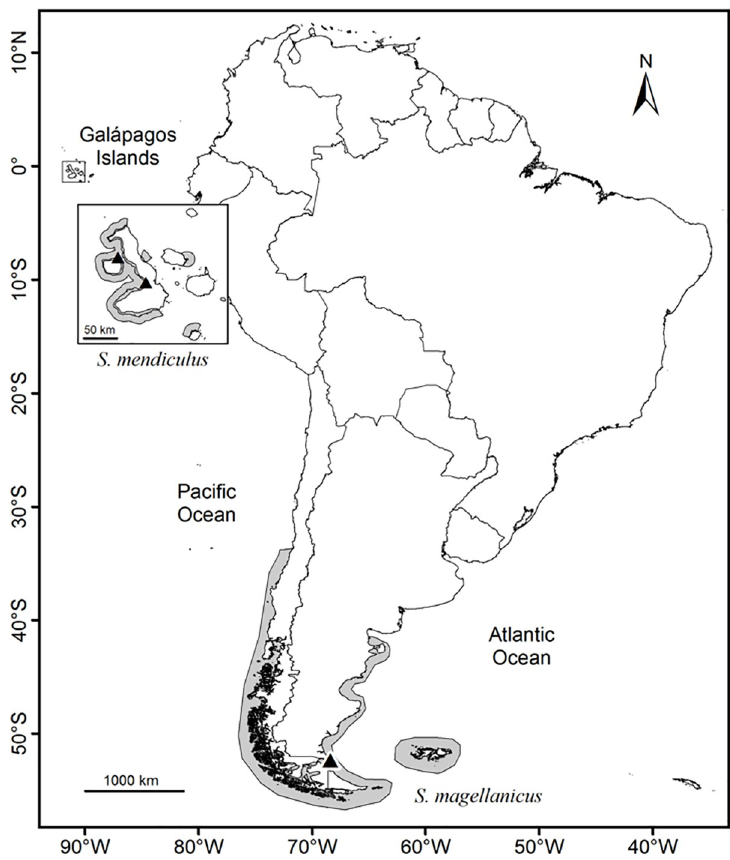
Fig 1. Map of South America overlaid with Spheniscus magellanicus (Magellanic penguin) and S . mendiculus (Gala´pagos penguin) breeding ranges (gray shading) and sampling localities for this study (triangles). The wide- ranging Magellanic penguin was sampled (N = 26) from a large breeding colony located at the southeastern tip of continental Argentina (Cabo Vı´rgenes). Endemic to the Gala´pagos Islands, the Gala´pagos penguin was sampled (N = 38) from Elizabeth Bay on Isabela Island, the largest island in the archipelago, as well as from Punta Espinoza on the nearby Fernandina Island. Spatial data for breeding ranges of the penguins was extracted from the global dataset of avian distribution maps